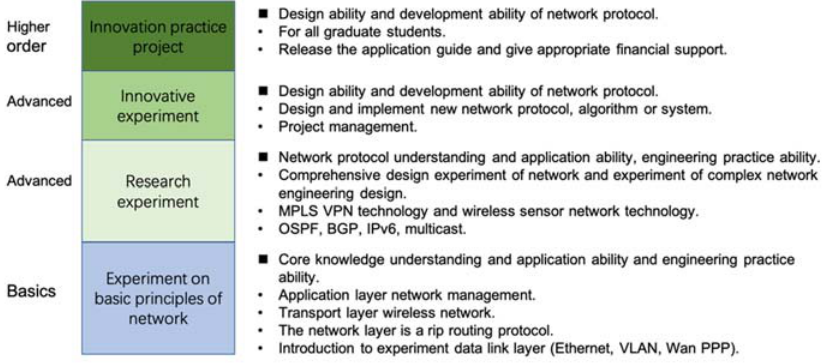
Figure 2. Multi-level integrated network experiment content of the research.